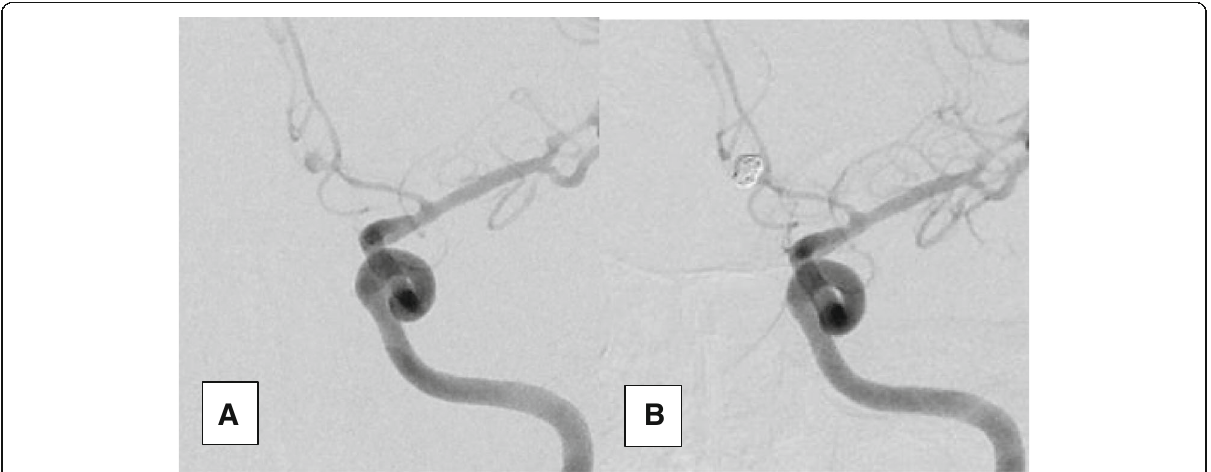
Fig. 1 A2 aneurysm before ( a ) and after ( b ) coiling showing complete obliteration (class I according to modified Raymond – Roy Classification). An associated vasospasm is noticed (before intra-arterial nimodipine